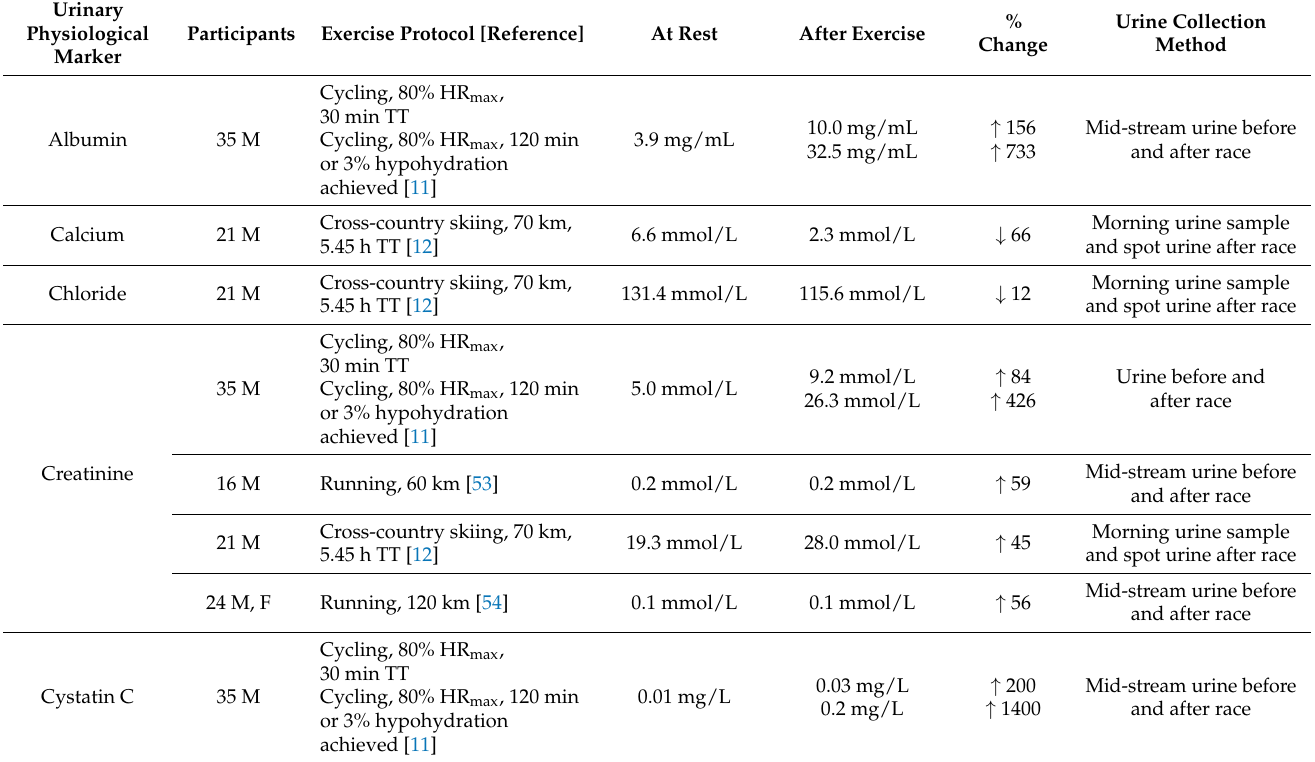
Table 2. Comparison of different urinary physiological markers at rest and after